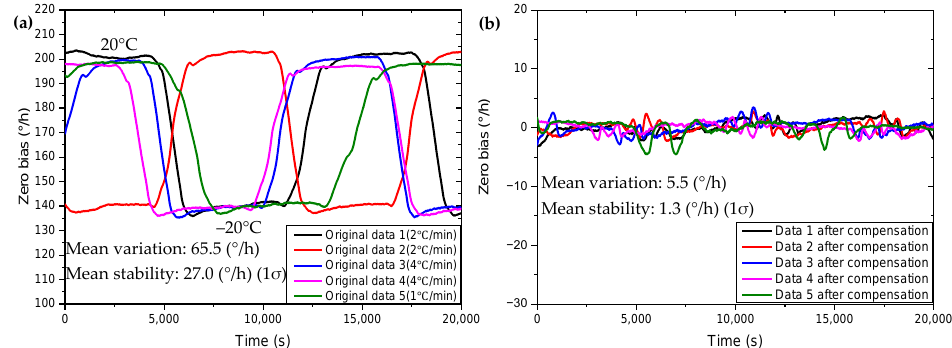
Figure 6. Zero-bias drift self-compensation results under different temperature change rates. ( a ) Before compensation. ( b ) After compensation.